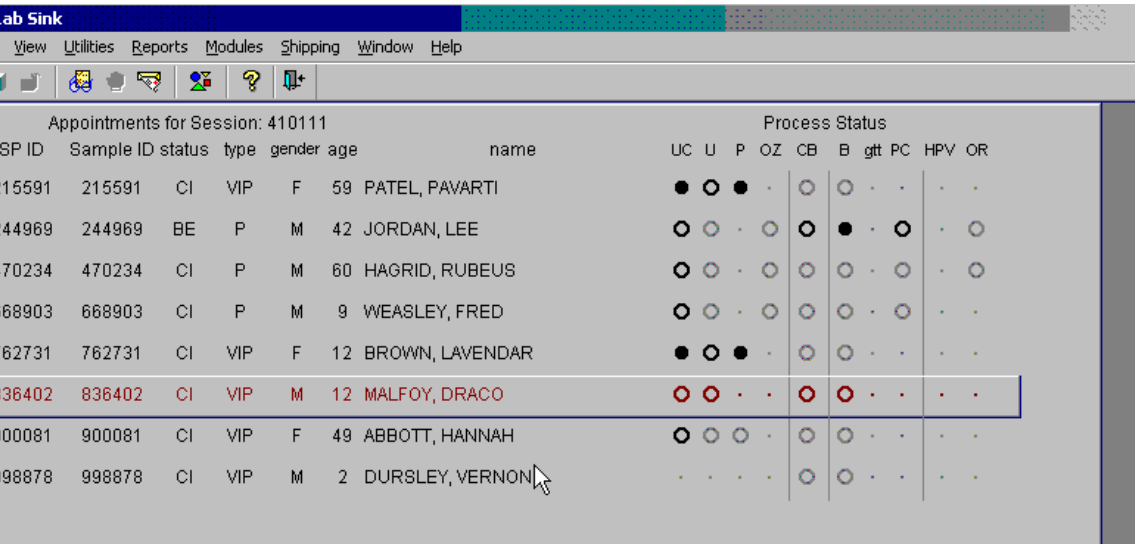
Regenerate the data for each MEC SP indicated in red on the heads-up display.